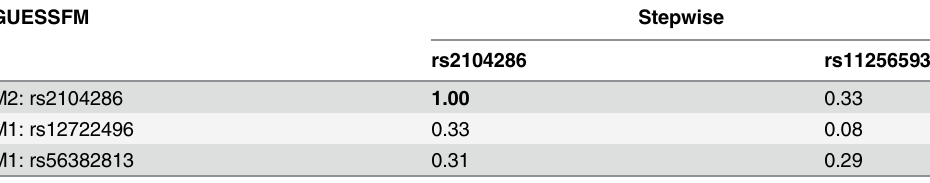
Table 3. LD ( r 2 ) between SNPs in selected models for MS using stochastic GUESSFM and stepwise searches. For the preferred M1 model for MS, there is only weak to moderate LD between SNPs chosen by GUESSFM and conditional